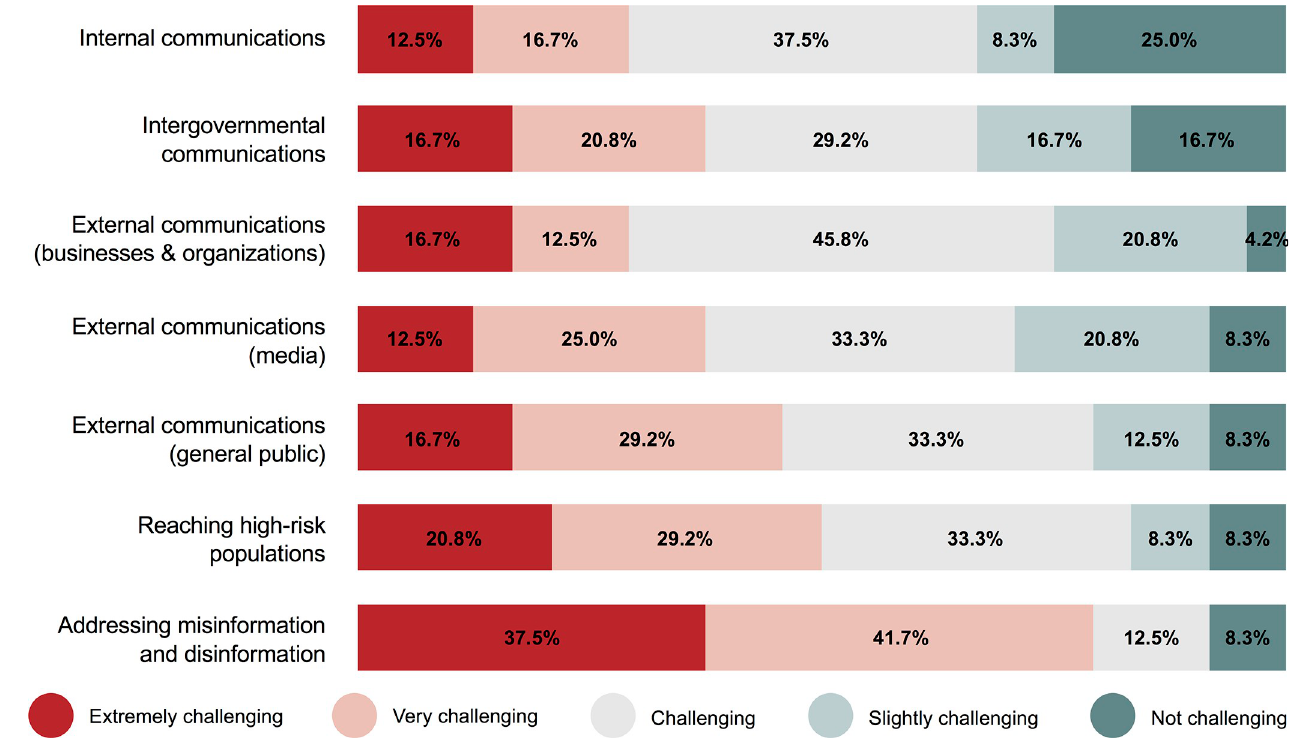
Fig 4. Likert-scale results regarding how challenging pandemic communication activities were perceived to be in cities (n = 24).